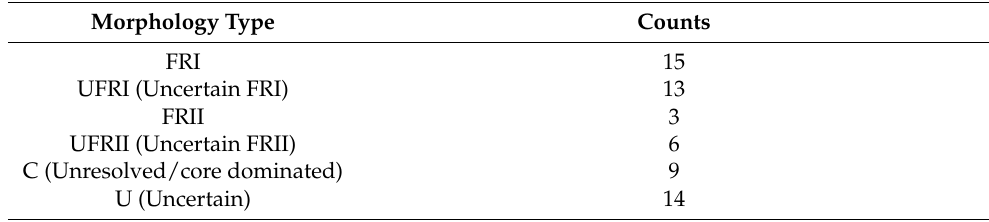
Table 1. Classification of the target sample using the follow up VLA